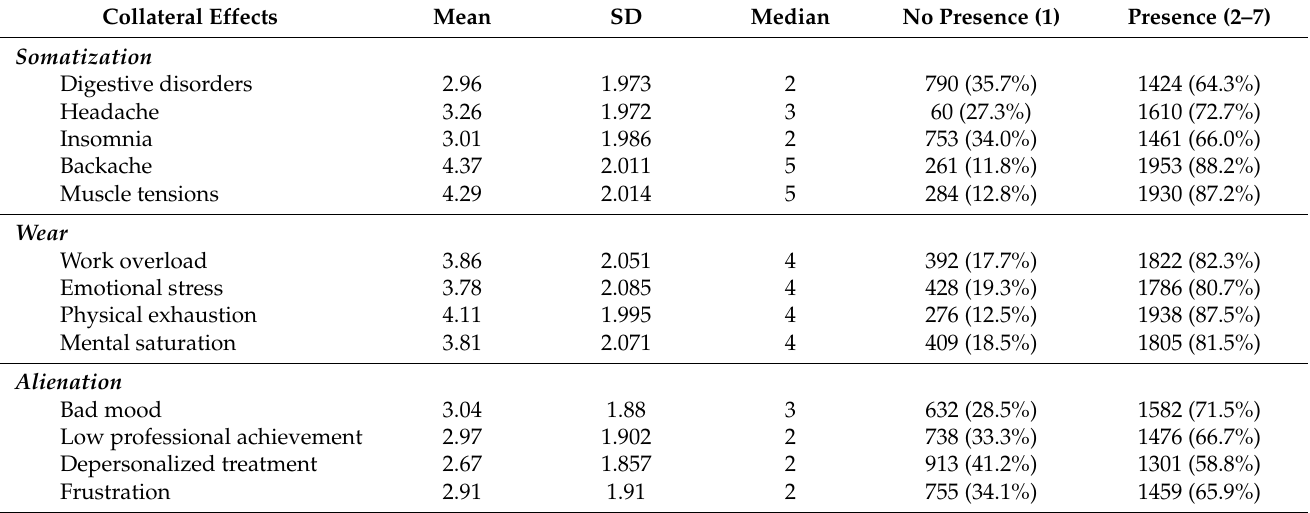
Table 3. Specific collateral effects in the participants.